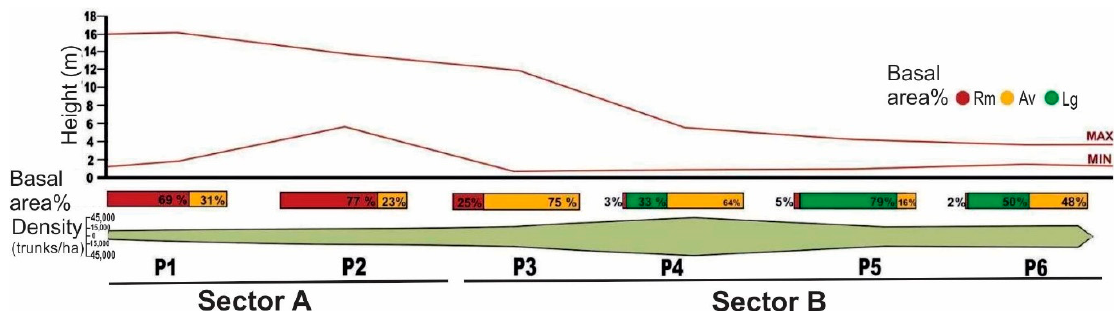
Figure 4. Graphic representation of the regeneration of the mangrove at Salina Margarida, showing the forest height in meters, and below the graph, bars showing the distribution of the basal area: red = R. mangle (Rm), yellow = A. germinans (Av), and green = L. racemosa (Lm). The mean density is also represented for each of the different sample areas (P1, P2, P3, P4, P5, and P6).